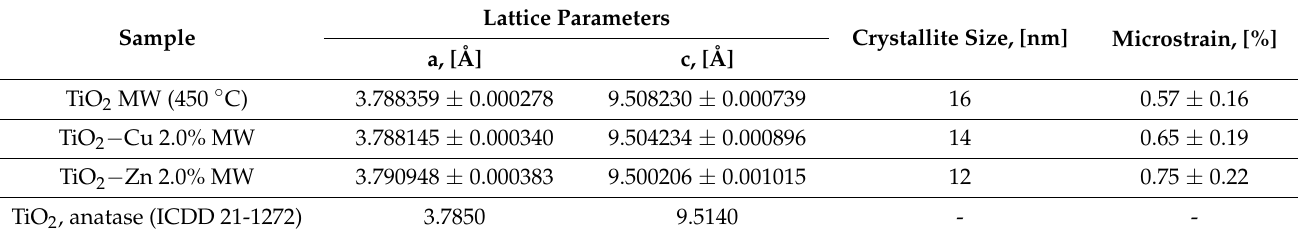
Table 4. Elemental composition of the analyzed samples.